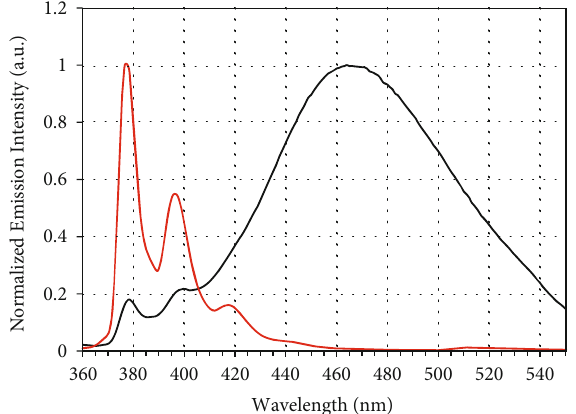
Figure 7: Normalized emission spectra of the Pyr − /LDH hybrid fi lm in air (black line, excited at 340 nm) and Pyr − aqueous solution ( 1 : 0 × 10 − 6 mol/L, red line, excited at 347nm).